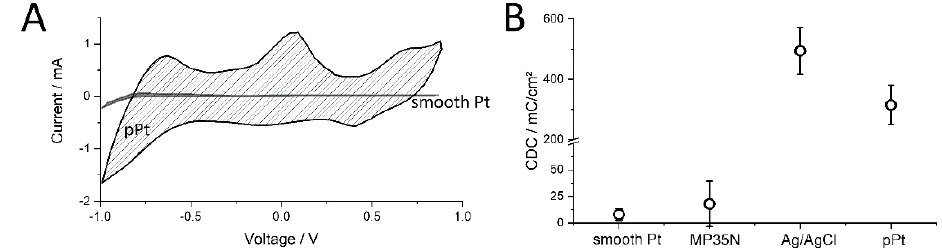
Figure 4. Cyclic voltammetry measurement. ( A ) Smooth platinum electrodes before and after electrochemical deposition of porous platinum (mean of 10 electrodes each). ( B ) Comparison of the charge delivery capacity (CDC) of MP35N (N = 7), Ag / AgCl (N = 7), smooth and porous platinum (pPt) electrodes (N = 10 each) of the same geometric area. Mean and standard